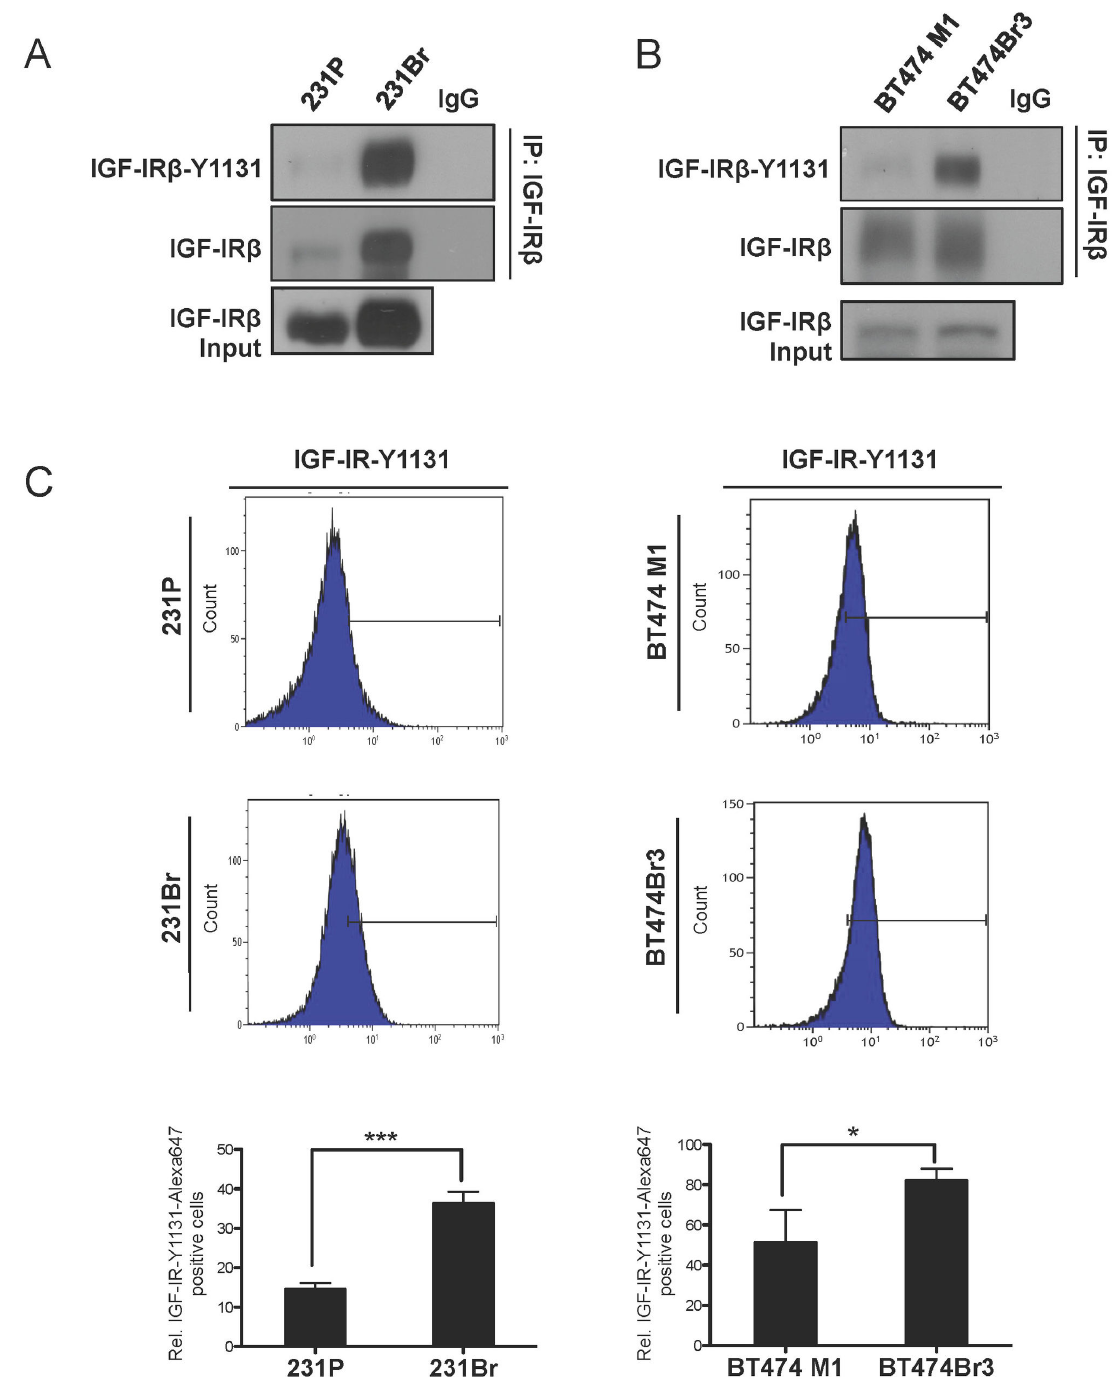
Figure 1. IGF-IR is activated in brain seeking breast cancer cells. A and B, Immunoprecipitates of IGF-IRβ from lysates of the parental MDA-MB-231 and BT474 breast cancer cells (231P, BT474 M1) and their respective brain-seeking sublines (231Br, BT474 BR3), were analyzed by SDS-PAGE and immunoblotted with antibodies against the IGF-IR Tyr1131 autophosphorylation site. Cells were serum-starved overnight prior to lysis. C, Flow cytometric analysis of IGF-IR activation in 231P & BT474 M1 breast cancer cells and respective brain-seeking sublines, 231Br and BT474 Br3, from (A and B). Cells were serum-starved for 24h and stained with AlexaFluor 647-phospho Y1131 IGF-IR antibody. Quantitation of flow cytometric analyses of fluorescent cells per group is shown below each panel. Values shown represent mean ± SEM from 3 replicates (*, p < 0.05, ***, p < 0.0005). doi: 10.1371/journal.pone.0073406.g001 PLOS ONE |